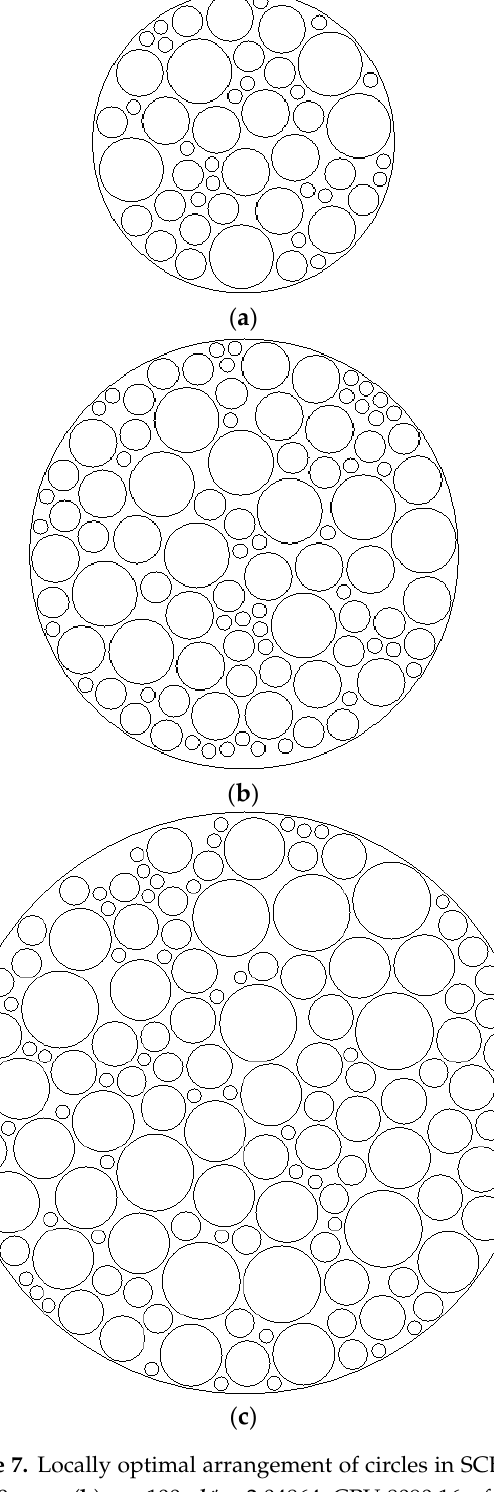
Figure 7. Locally optimal arrangement of circles in SCBP: ( a ) n = 50, d * = 2.05510, CPU 1201.32 s for 100 runs; ( b ) n = 100, d * = 2.04864, CPU 8090.16 s for 100 runs; ( c ) n = 150, d * = 2.05183, CPU 19571.66 s for 100 runs, CPU 8090.16 s for 100 runs.